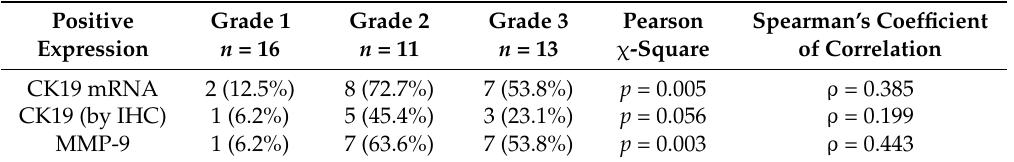
Table 3. Correlation between grading of primary breast carcinoma and three markers: CK19 mRNA, CK19 (by IHC), and